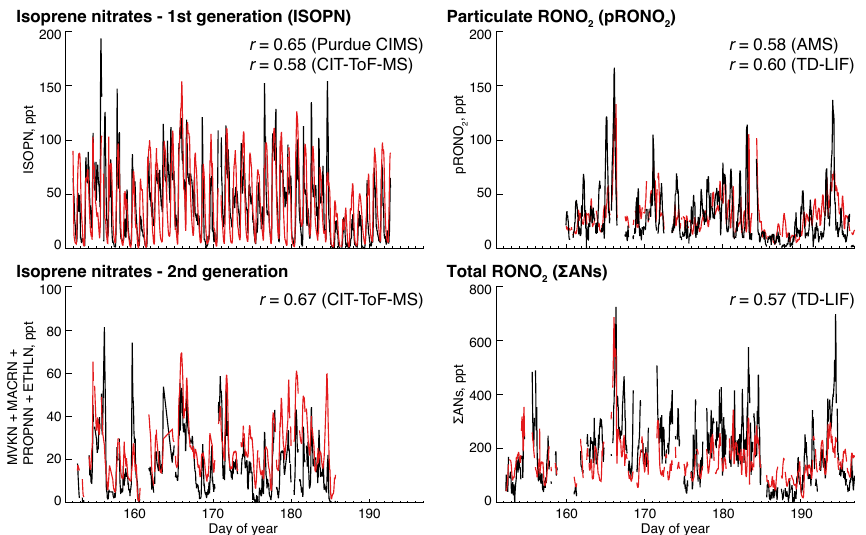
Figure 8. Time series of observed (black) and simulated (red) hourly mean RONO 2 at Centreville during the 2013 SOAS campaign for first generation isoprene nitrates (ISOPN, from the Purdue CIMS), second generation isoprene nitrates (MVKN + MACRN + PROPNN + ETHLN from the CIT-ToF-CIMS), particulate RONO 2 (pRONO 2 , from the AMS) and total alkyl and multifunctional nitrates ( (cid:54) ANs, from the TD-LIF). The model has been sampled in the Centreville grid box only for hours with available data from each instrument. The model– observation correlation coefficient ( r ) for each species is given inset both for the measurement shown and (where available) for additional measurement of the same species (with time series shown in Fig. S4).